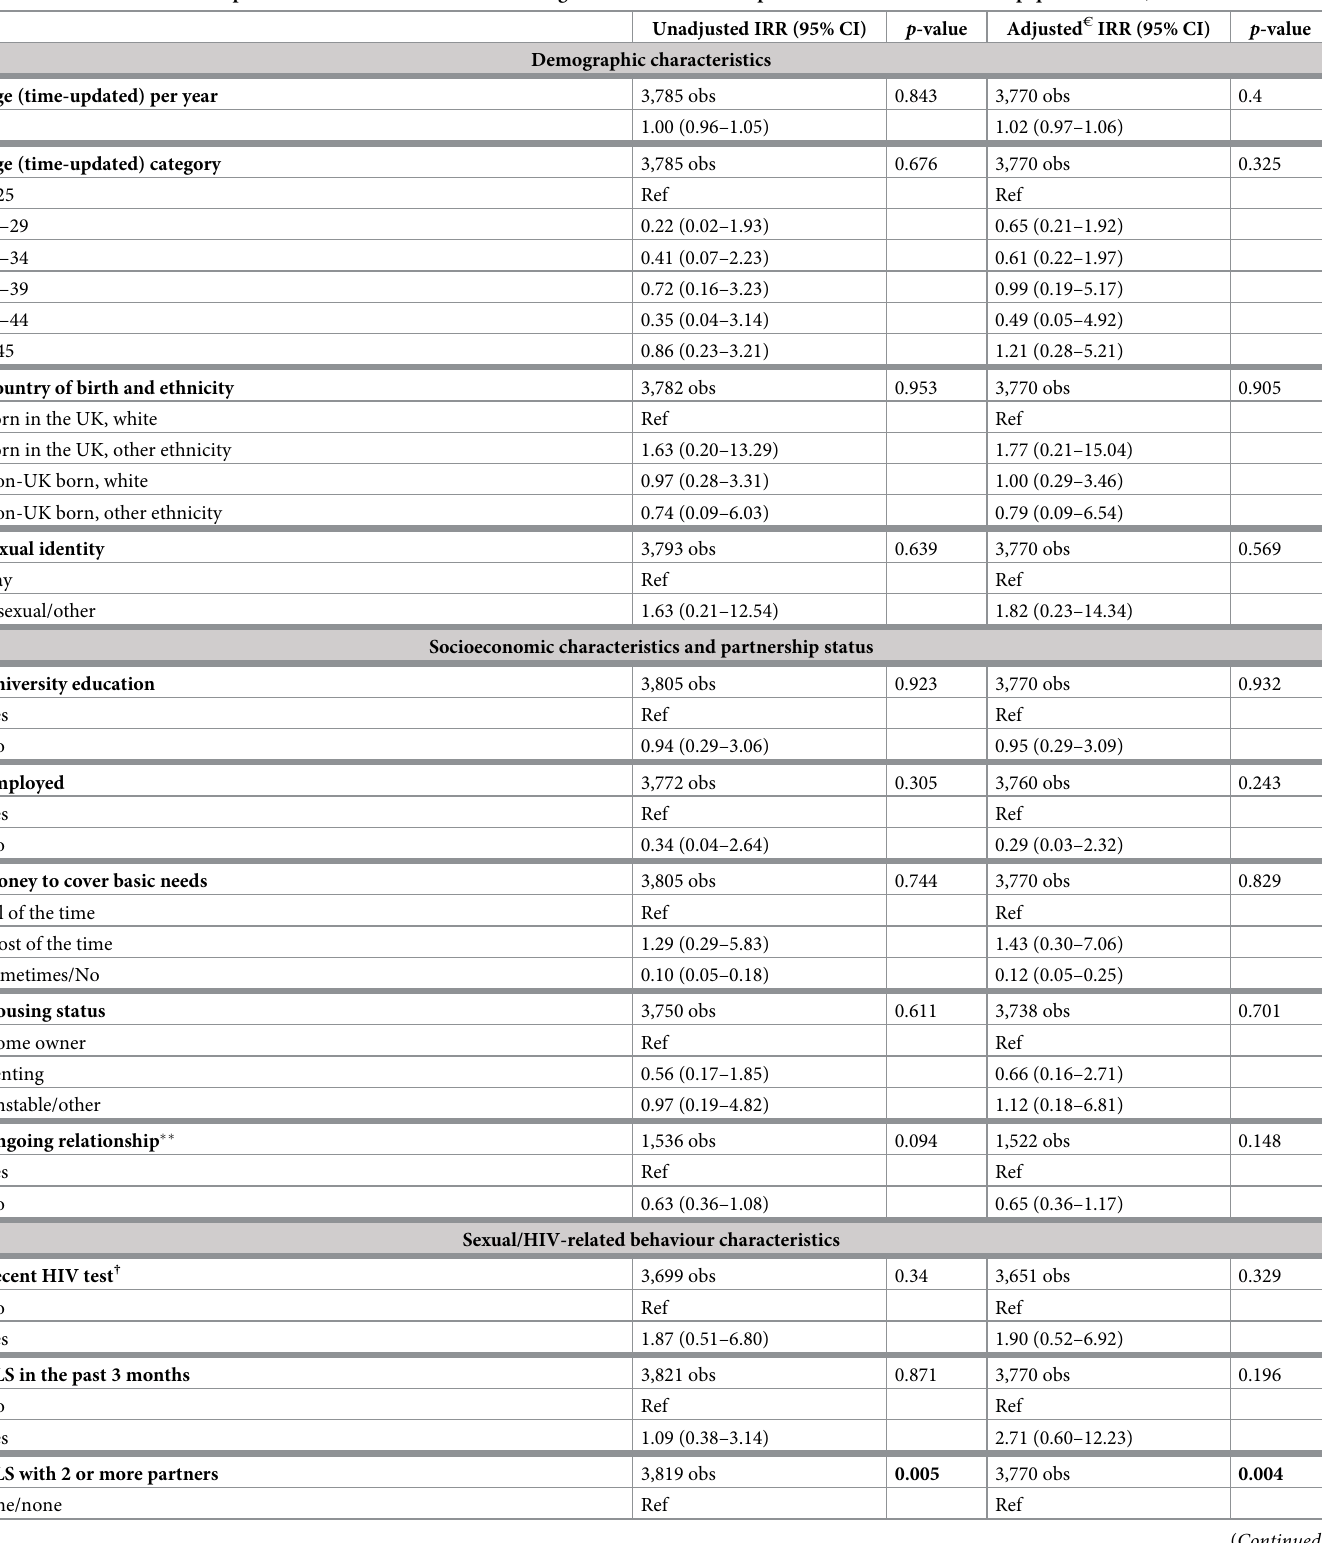
Table 3. Association of time-updated factors with incident HIV among 622 GBMSM who completed at least 1 online follow-up questionnaire, 2013–2018 �